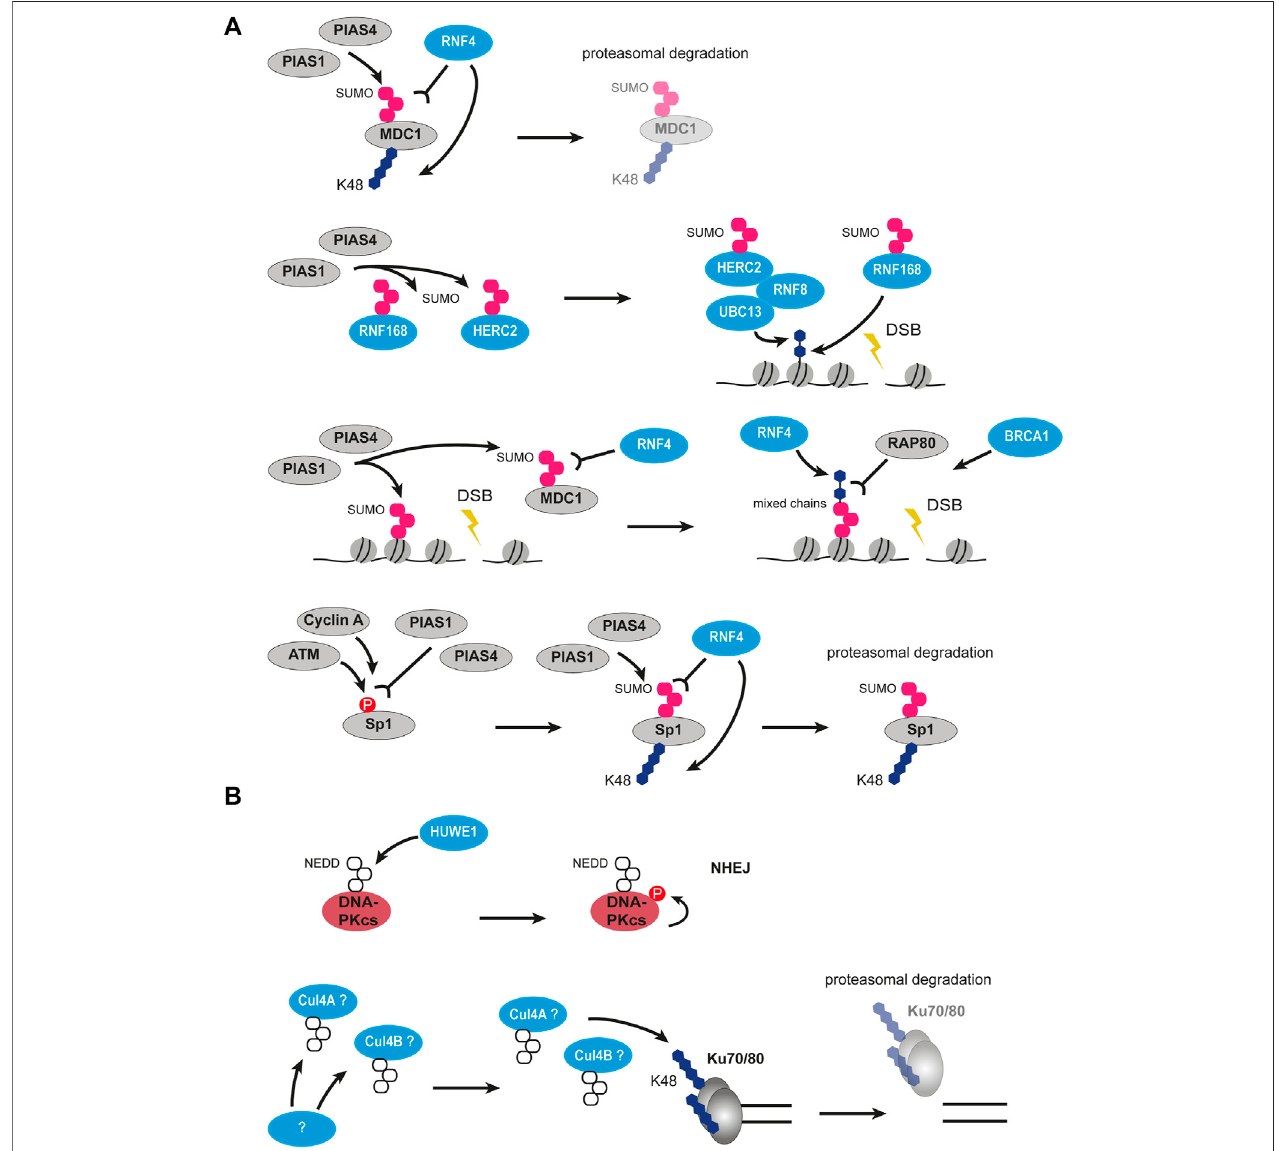
FIGURE 6 | Crosstalk between SUMOylation and ubiquitination, as well as NEDDylation and ubiquitination in DSB signaling and repair. (A) Crosstalk between SUMOylationandubiquitination.MDC1canbeSUMOylatedbyPIAS1andPIAS4andthenrecognizedbyRNF4leadingtoitspolyubiquitinationanddegradation.PIAS1 and PIAS4 can also SUMOylate RNF168 and HERC2 leading to their activation. Activated HERC2 interacts with RNF8 and UBC13 and ubiquitinates histones together withactivatedRNF168.PIAS1andPIAS4-mediatedSUMOylationofMDC1andhistonesrecruitsRNF4,whichbuildsmixedSUMO-ubiquitinchainsrecognizedby RAP80. Phosphorylated Sp1 is recognized PIAS1 and PIAS4 leading to its SUMOylation. SUMOylated Sp1 is recognized by RNF4 and gets polyubiquitinated and degraded. (B) Crosstalk between NEDDylation and ubiquitination.HUWE1ubiquitin ligase can NEDDylate DNA-PKcsleading toits autophosphorylationand promoting NHEJ. NEDDylation of potentially cullins leads to polyubiquitination of Ku70/80 and their degradation. The enzyme performing NEDDylation is unknown. P, phosphorylation; SUMO, SUMOylation; NEDD8, NEDDylation; U, ubiquitin.